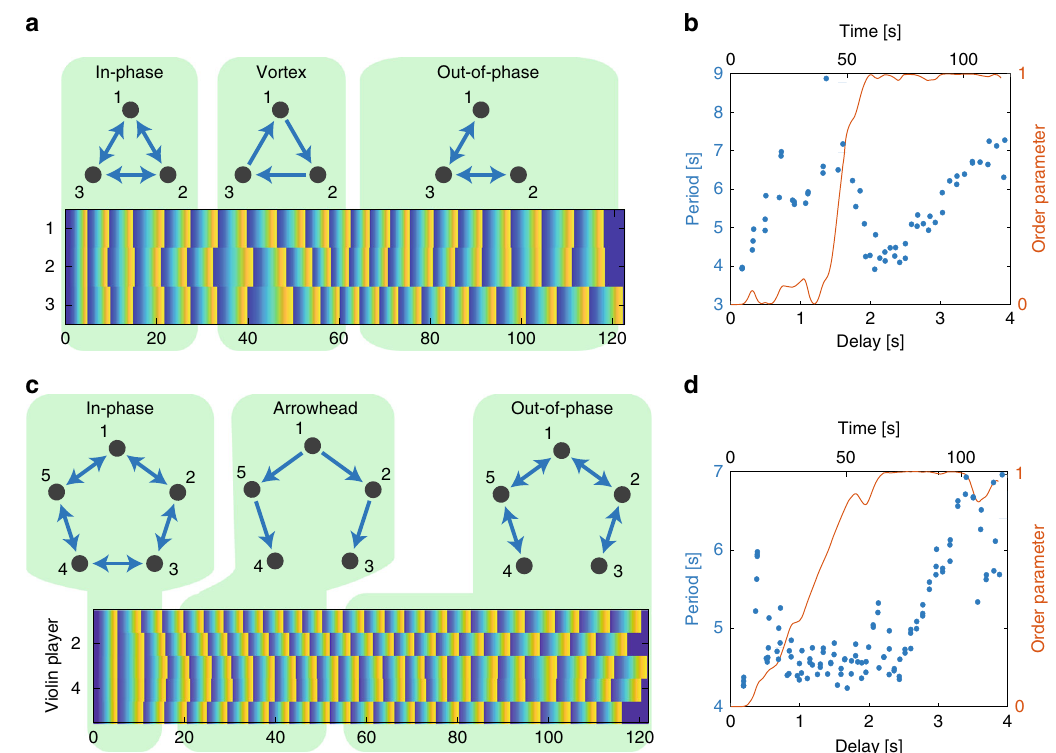
Fig. 5 Three and fi ve coupled violin players. In the con fi gurations of three and fi ve coupled players, the out-of-phase synchronization state is no longer stable. In these cases, the players change the connectivity and ignore one of the links, reducing the system to an open chain where out-of-phase synchronization is stable again. a Three coupled players showing in-phase, vortex, and out-of-phase states of synchronization. b The playing period and the open-chain out-of-phase order parameter as a function of time and the delay, showing that once the players obtain an out-of-phase synchronization state, they maintain it by increasing the playing period with the delay. c Five coupled players, showing in-phase, arrowhead, and out-of-phase states of synchronization. d The playing period and the open-chain out-of-phase order parameter, showing the same behavior as the three coupled